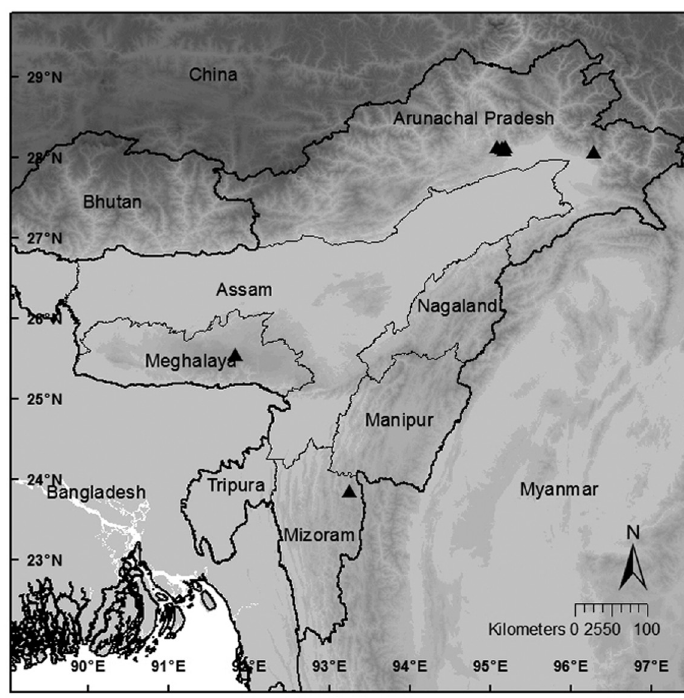
Fig. 37. Map showing the location of B. longifolia Blume